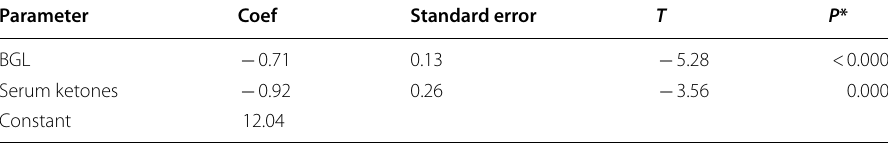
*Statistical significance ( P < 0.05)